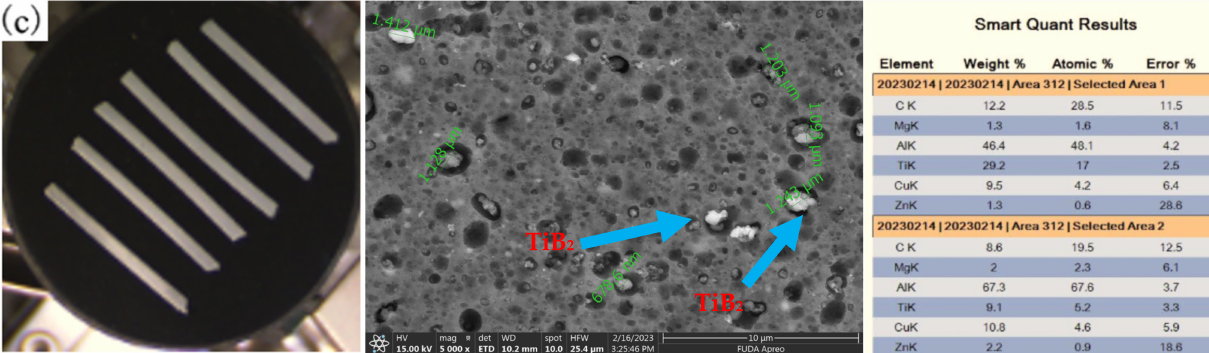
Figure 4. Macro images and SEM scanning images of welding wire. ( a ) Macro images of welding wire. ( b , c ) SEM scanning images of welding wire.